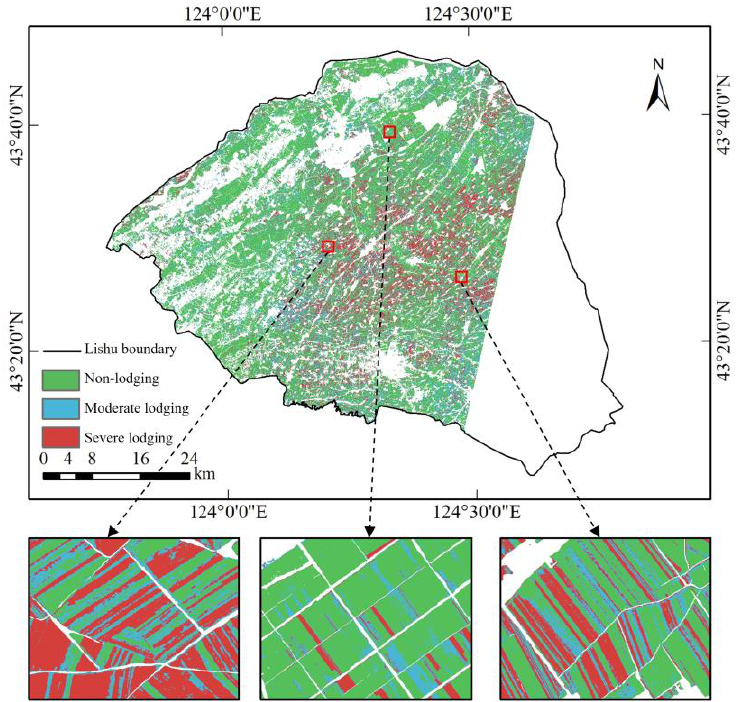
Figure 14. Mapping of corn non-lodged, moderately lodged, and severely lodged areas in the study area using GF-1 PMS images.